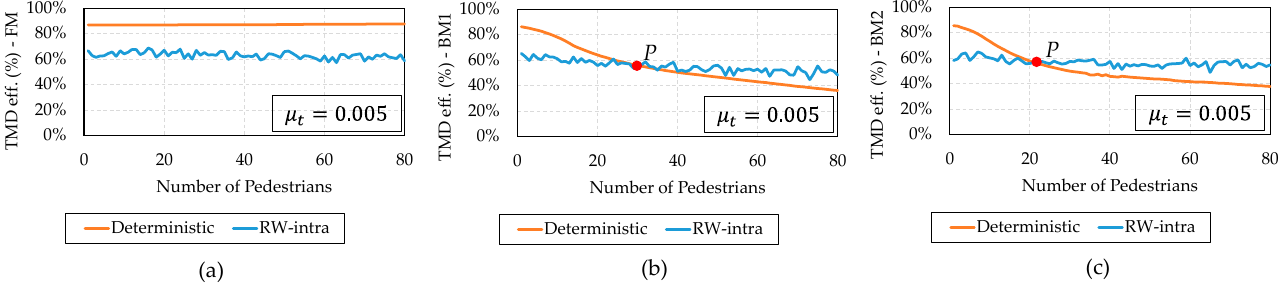
Figure 8. The TMD efficiency for the sensitivity of RW-intra responses, µ t = 0.005 and CoV = 50%. ( a ) FM, ( b ) BM1, and ( c ) BM2